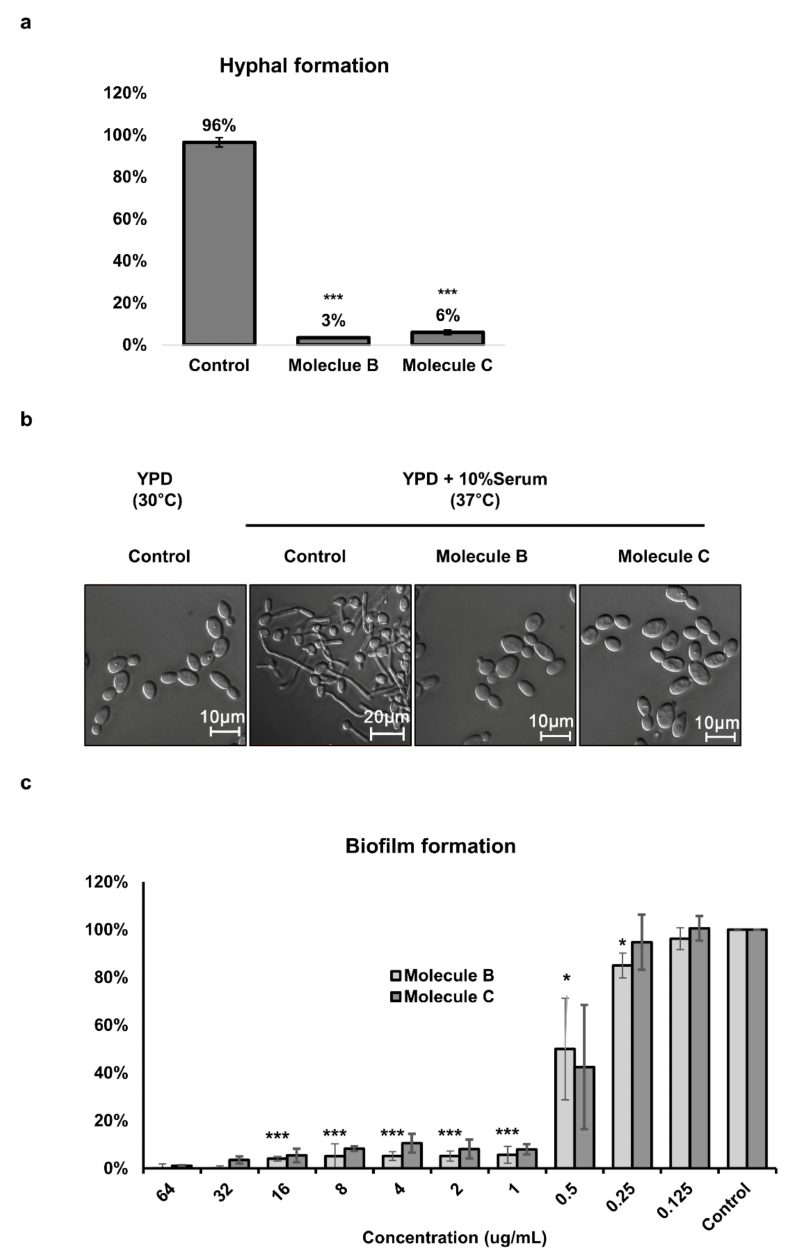
Figure 2. Inhibitory effect of Molecule B and Molecule C on morphogenesis and biofilm formation in C. albicans. ( a ) The inhibitory effects of Molecule B and Molecule C on the hyphal formation of C. albicans SC5314. To induce hyphae formation, YPD with 10% FBS was used and incubated for 2 h at 37 ◦ C. Molecule B was treated at 8 µ g/mL, and Molecule C was treated at 16 µ g/mL. ( b ) A minimum of 300 C. albicans SC5314 cells were counted for each treatment to evaluate the morphogenesis inhibitory effect as a percentage. To observe the morphology change using a microscope, Molecule B and Molecule C were administered at each MIC. Scale bars represent 10 µ m (yeast form) and 20 µ m (hyphae). ( c ) The inhibitory effect of Molecule B and Molecule C on C. albicans biofilm formation. Biofilms were formed by inoculation 2 × 10 4 C. albicans SC5314 cells/mL in 200 µ L cell suspension into 96-well flat-bottomed microtiter plates adding Molecule B and Molecule C to final concentrations ranging between 0.125 and 64 µ g/mL and incubating at 37 ◦ C for 24 h. A metabolic assay based on the reduction of XTT was performed to determine the biofilm formation inhibitory concentrations. Colorimetric absorbance was measured at 495 nm in a microtiter plate reader. Each experiment was conducted in triplicate. The data represent the mean and standard deviation of three independent experiments. * p < 0.05, *** p < 0.001 ( t